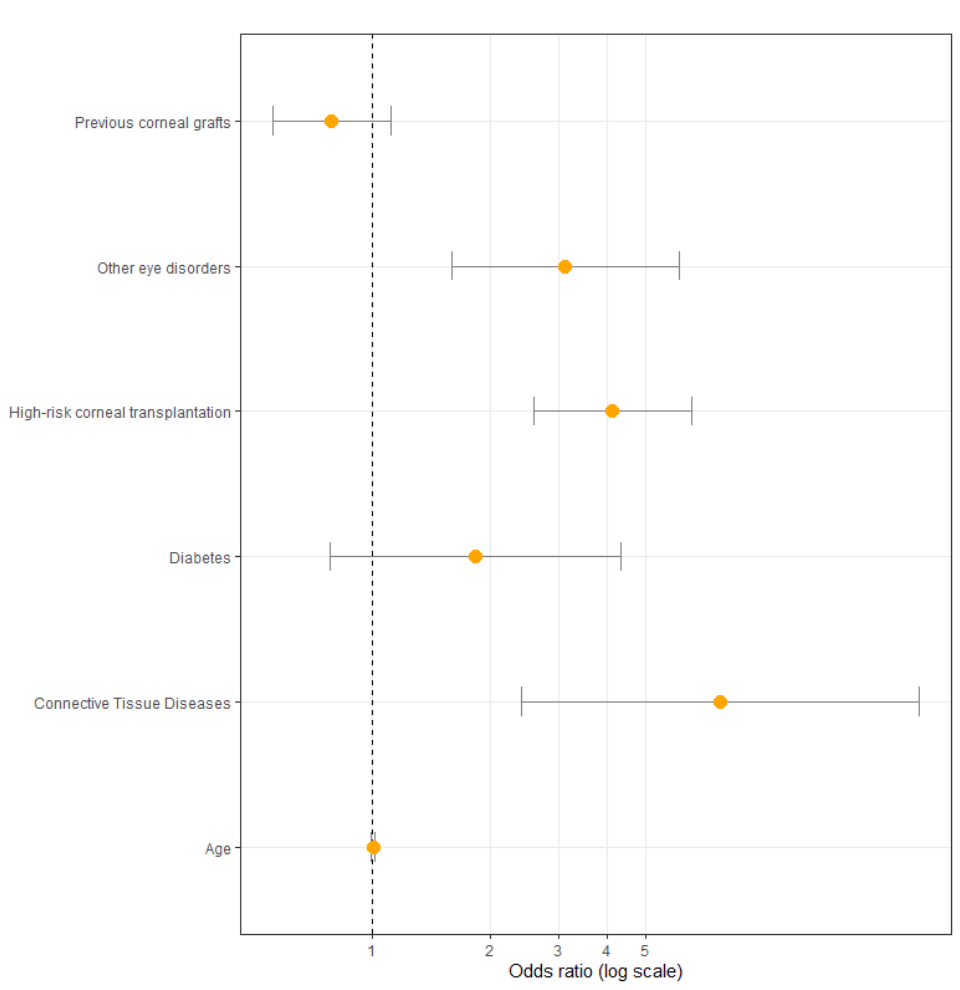
Figure 4. Odds ratio with confidence intervals of the studied factors included in multivariate anal ‐ ysis.